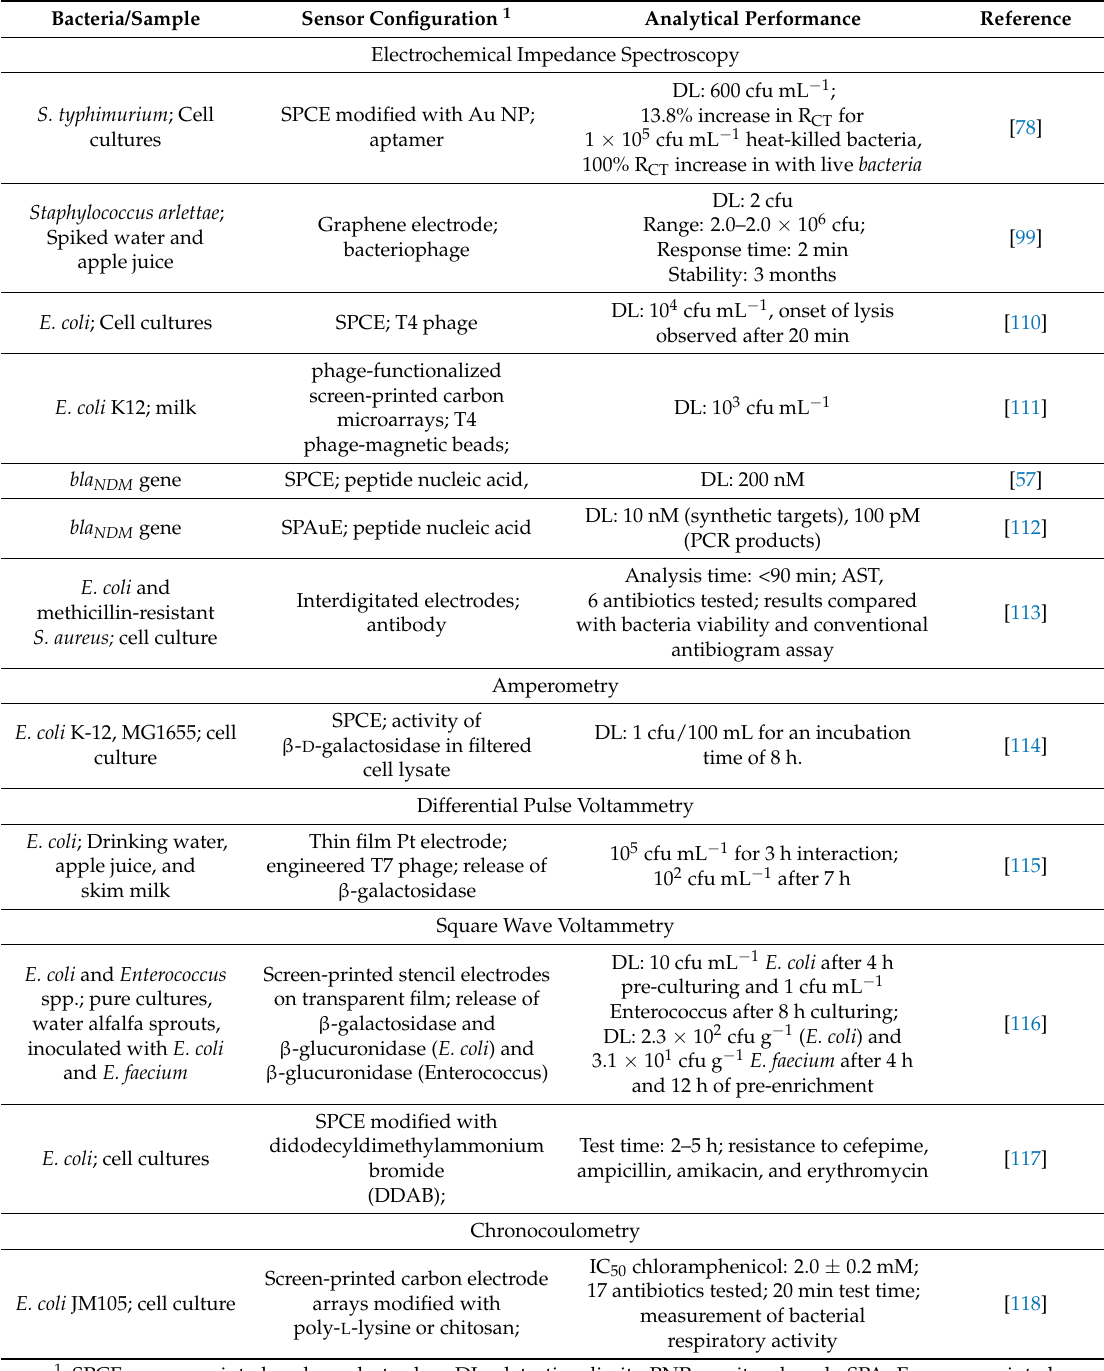
Table 2. Examples of biosensors based on screen-printed electrodes for the detection of bacteria and evaluation of antibiotic